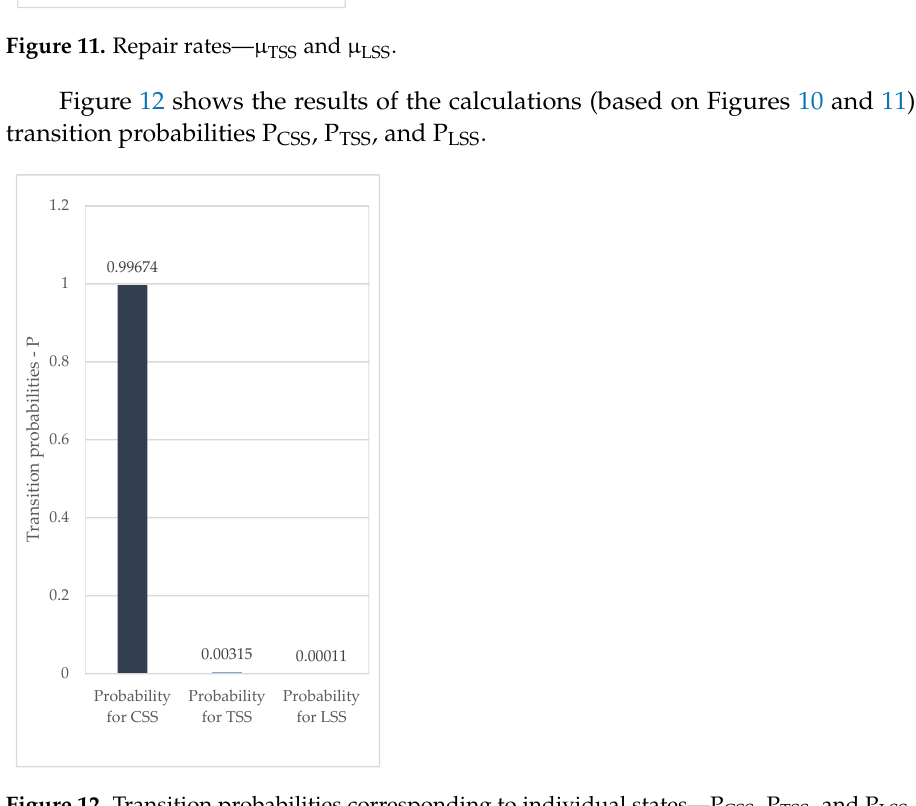
Figure 1 1. Repair rates —µ TSS and µ LSS Figure 11. Repair rates— µ